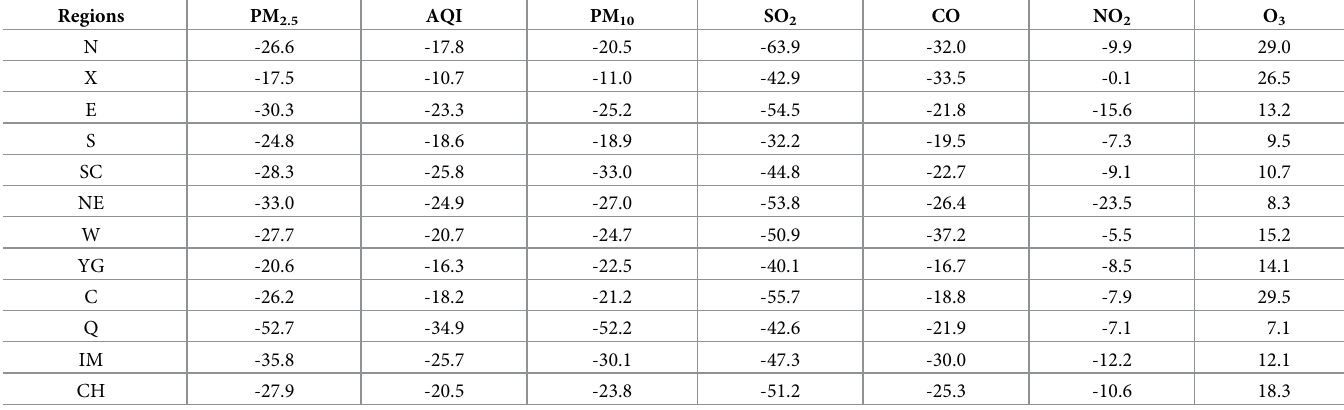
Table 3. Relative change (%) of pollutants between 2015 and 2019, regions are indicated by the first capital letter. Regions N